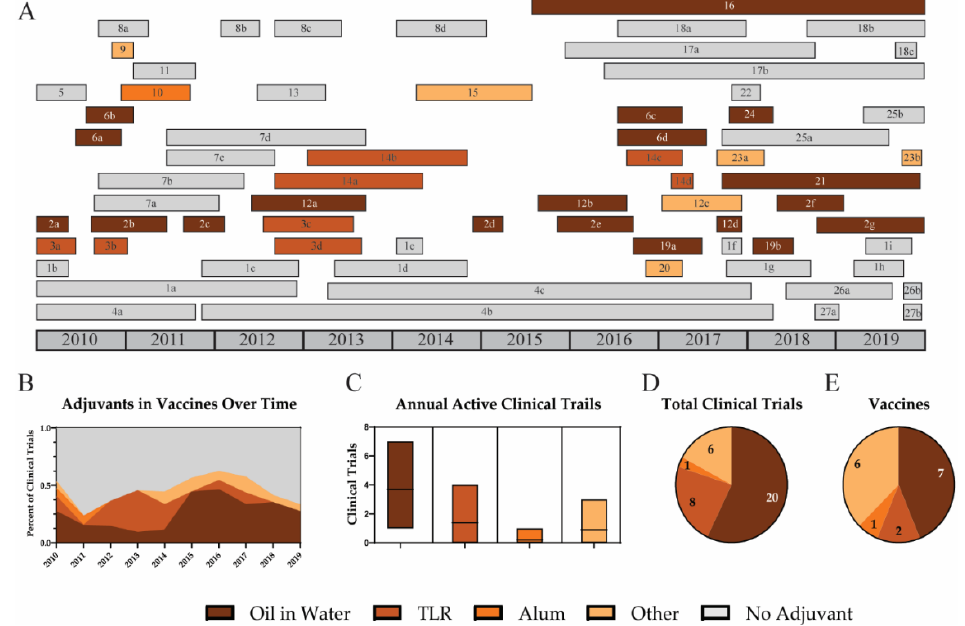
Figure 4. Adjuvants in universal influenza vaccine clinical trials. A timeline for adjuvants used for universal influenza vaccine clinical trials is shown for oil-in-water (dark brown), TLR agonists (brown), alum (orange), other adjuvants (light orange), and trials that did not use an adjuvant (grey) ( A ). Trends for the inclusion of various adjuvants are shown by the percent of active clinical trials each year ( B ). The average number of active clinical trials each year ( C ), the total number of clinical trials ( D ), and number of vaccines using each adjuvant during the decade are reported ( E ).